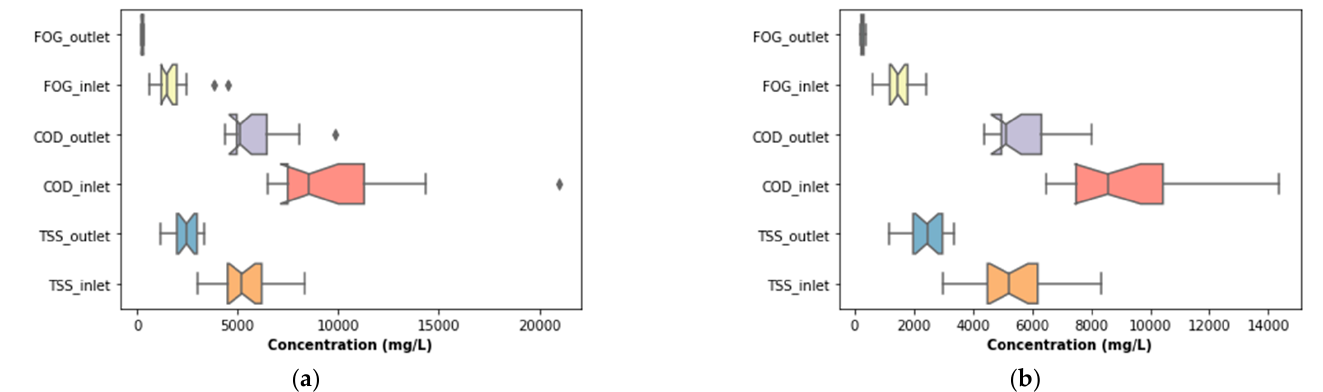
Figure 8. Boxplots of highlighted features before and after outliers’ replacement: ( a ) Boxplots before outliers’ replacement; ( b ) Boxplots after outliers’ replacement.